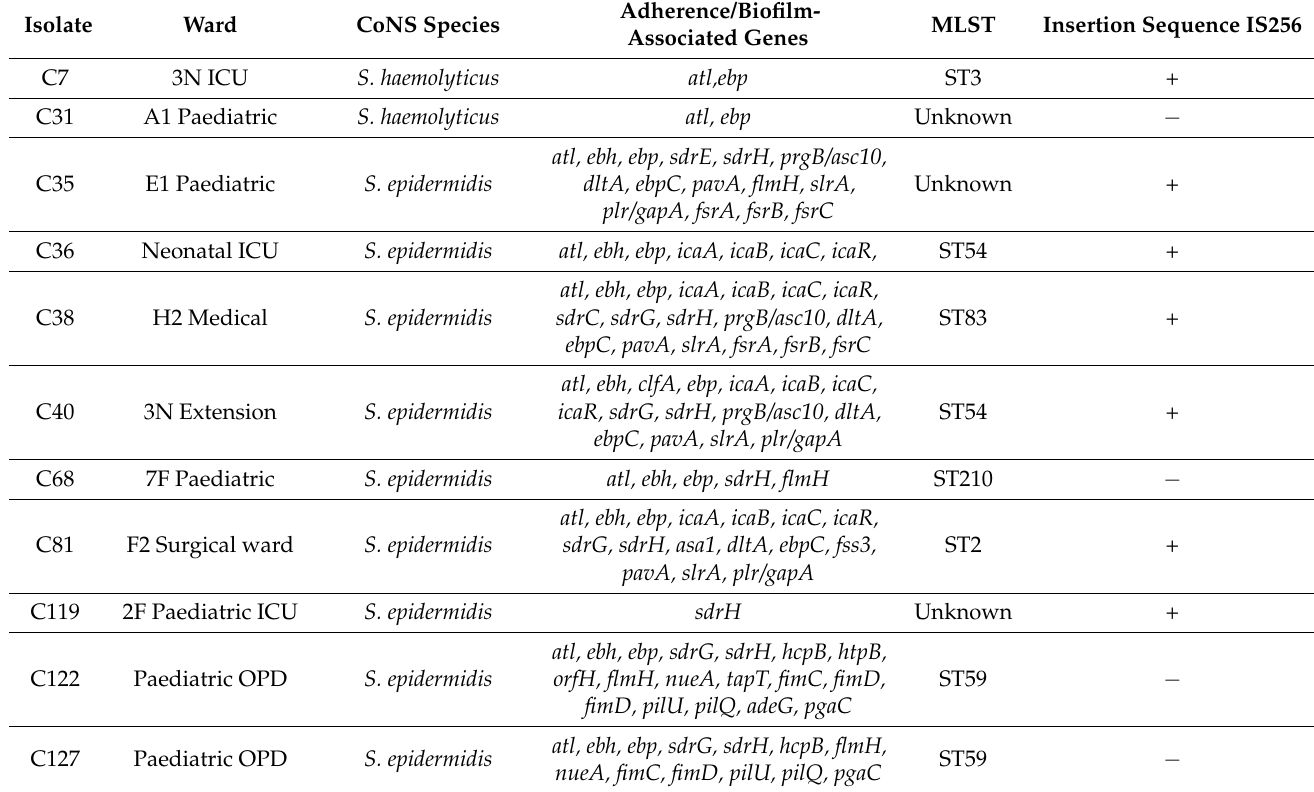
Table 2. Biofilm/adherence-related genes found in